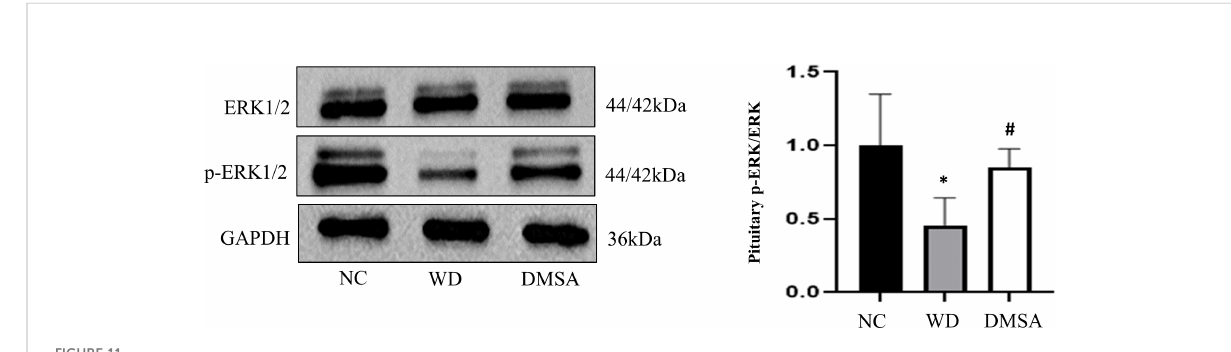
FIGURE 11 ERK1/2 phosphorylation in the male pituitary. Data are presented as mean ± SD.(*P<0.05, NC group vs. WD group; # P<0.05, WD group vs. DMSA group).